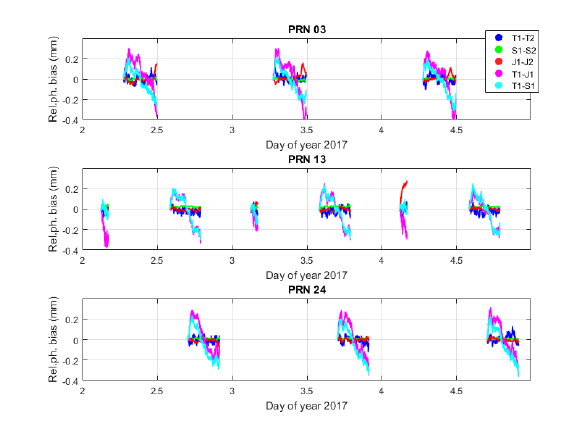
Figure 6: Residuals over time DOY 2-4 for phase biases T1-J1